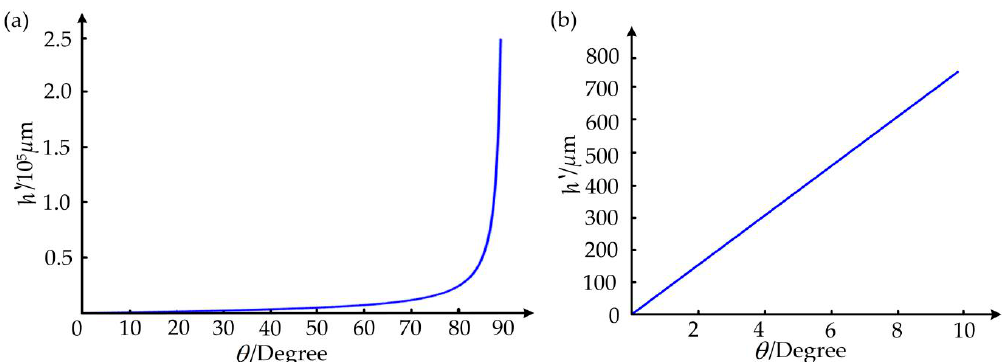
Figure 7. ( a ) Relationship between the moving distance of the movable super-diffraction optical needle (MSON) relative to the optical axis and the oblique incidence angle. ( b ) When the oblique axis and the oblique incidence angle is incidence angle is less than 10°, the relationship between the moving distance of the MSON relative